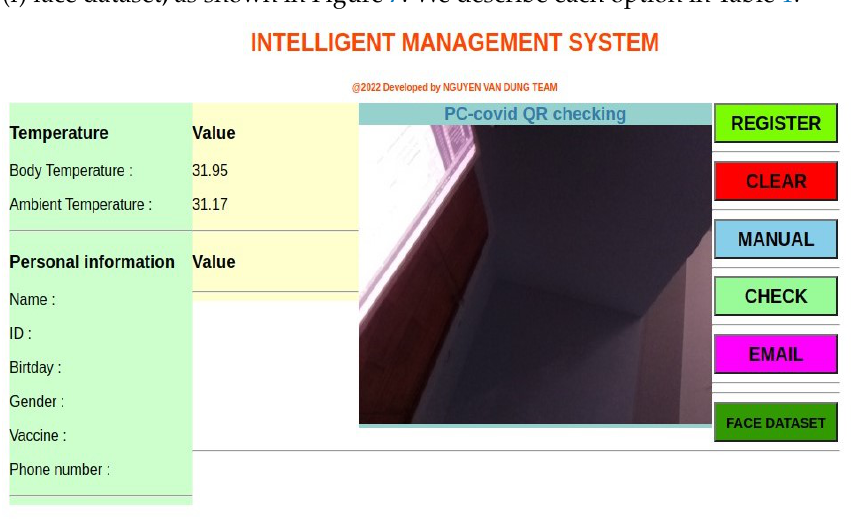
Figure 7. Web application display. Table 1. Options in our attendance